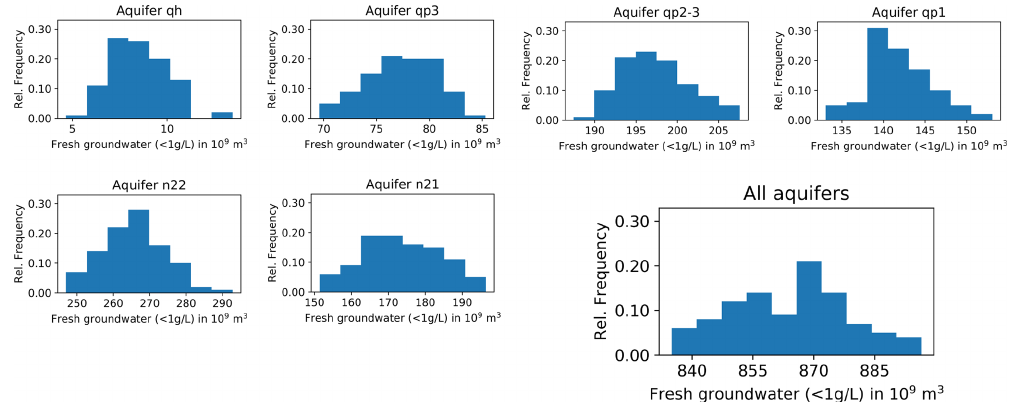
Figure 14. Estimated volumes of fresh groundwater (TDS < 1gL − 1 ) for each aquifer and for all aquifers combined, based on 100 Monte Carlo realizations obtained by indicator simulations. Note that the units on the horizontal axes vary.